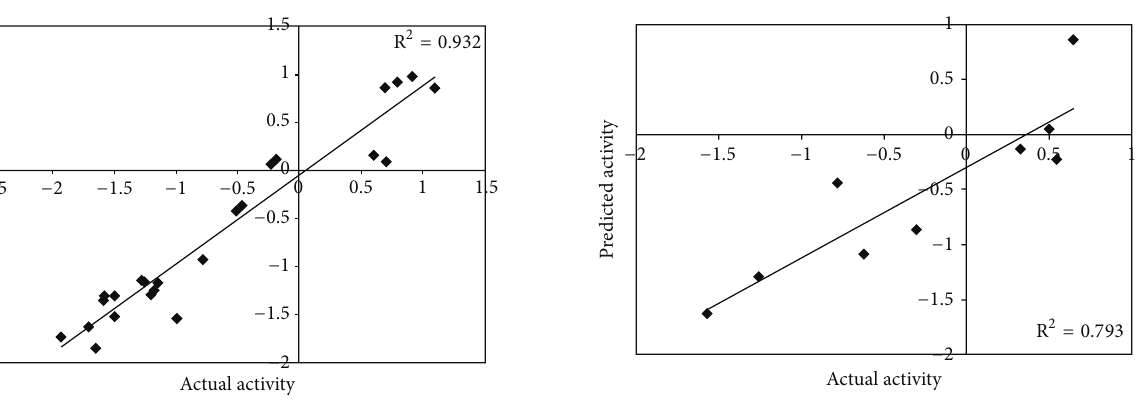
Figure 2: Plot of actual versus predicted values for the training set molecules with the help of PLS statistical method.